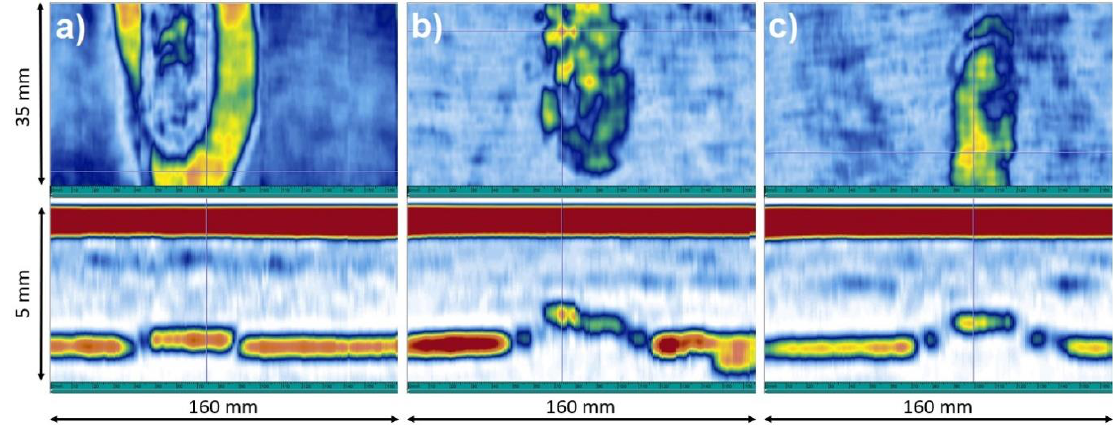
Figure 13. Images of samples after a lightning strike and ultrasonic tests for ( a ) L_ref, ( b ) L_TP and ( c ) L_ECF, where C-Scan ( top ) and B-Scan ( bottom ) visualization.